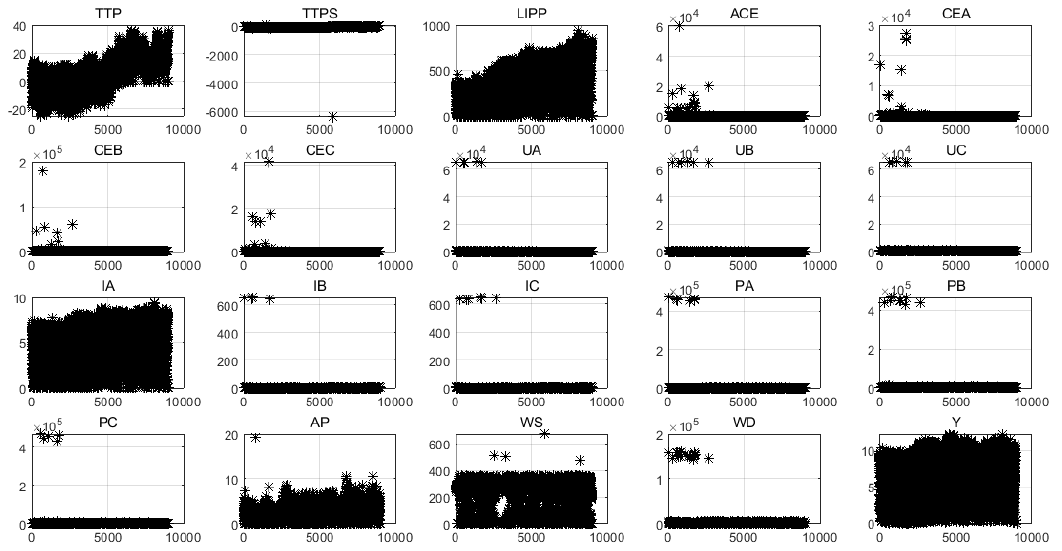
Figure 3. Visual analysis of 20